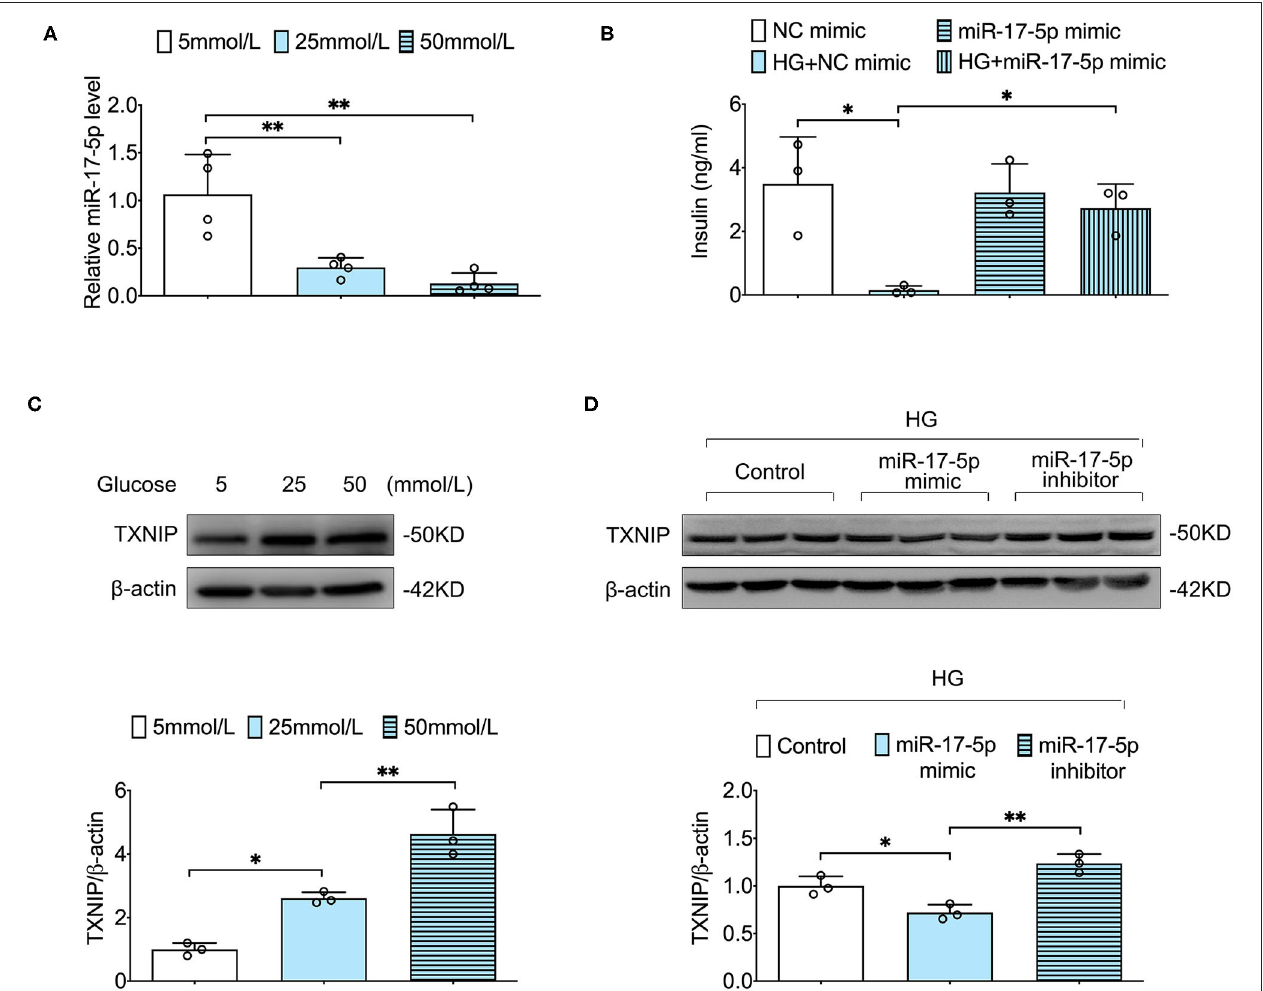
FIGURE 1 | The effect of high glucose on expression of miR-17-5p, TXNIP, and GSIS in INS-1 cells. (A) The relative levels of miR-17-5p under different concentrations of glucose were analyzed by qRT-PCR. (B) Effects of high glucose and miR-17-5p on GSIS. (C) Representative blots and quantitative analysis showing the expression of TXNIP in INS-1 cells treated with different concentrations of glucose. (D) The effects of miR-17-5p on the expression of TXNIP in INS-1 cells. Control: 5 mmol/L; HG (high glucose): 25 mmol/L. * p < 0.05 and ** p <